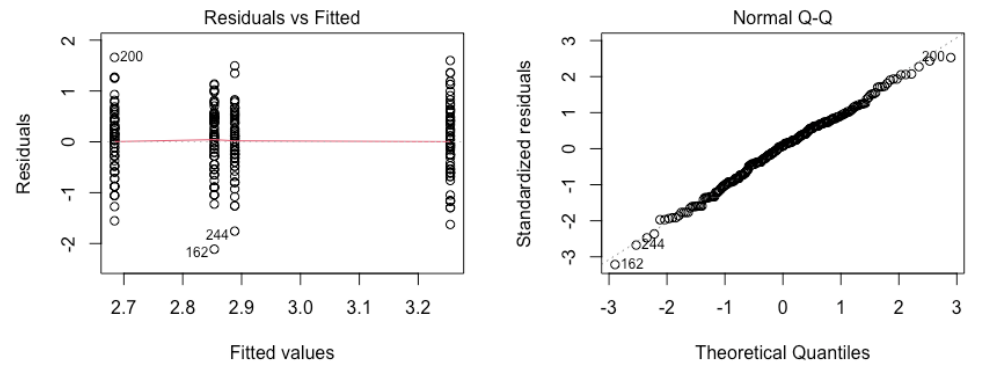
Figure A3. Error Distribution Analysis.